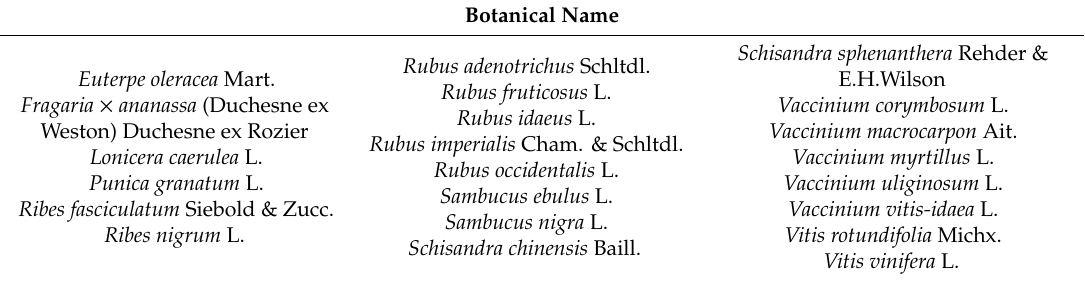
Table 1. List of the berries plant species investigated at cutaneous level and included in this